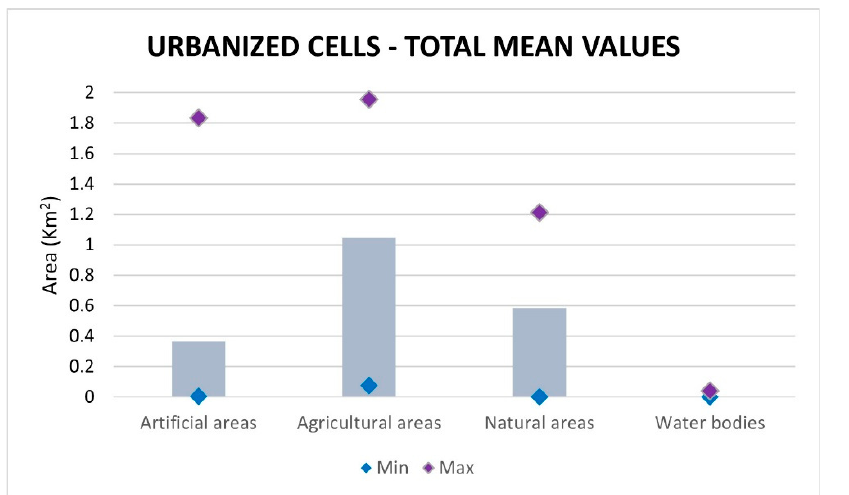
Figure 10. Area covered by each UA class, resulting from all the dissolved shifts for the five UA classes K—Means method.